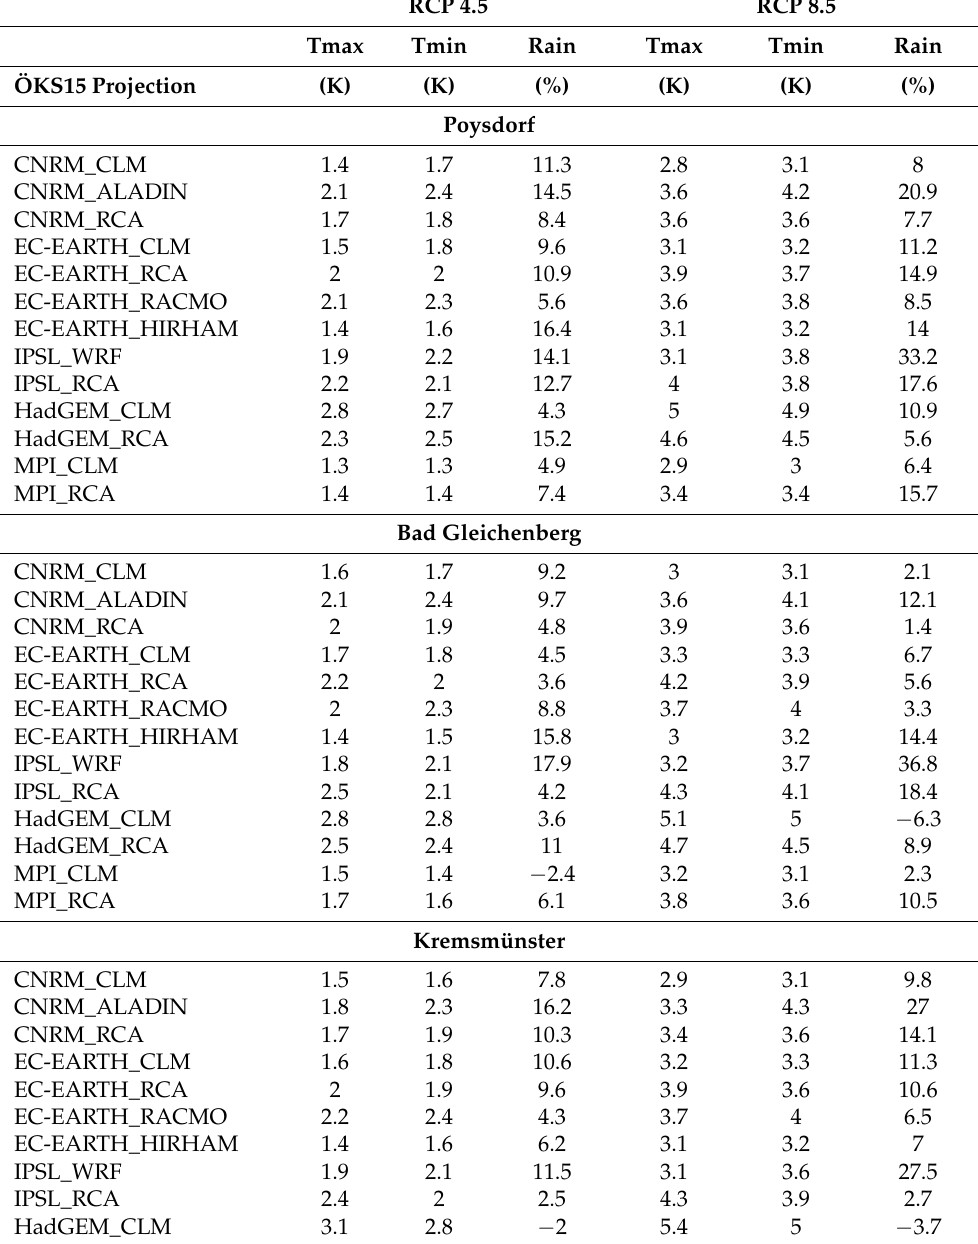
Table A1. Annual differences in the maximum (Tmax) and minimum temperatures (Tmin) in K and the precipitation (Rain) as a % in Poysdorf, Bad Gleichenberg, and Kremsmünster for the 13 ÖKS15 projections (RCP 4.5 and RCP 8.5): 2071–2100 vs.